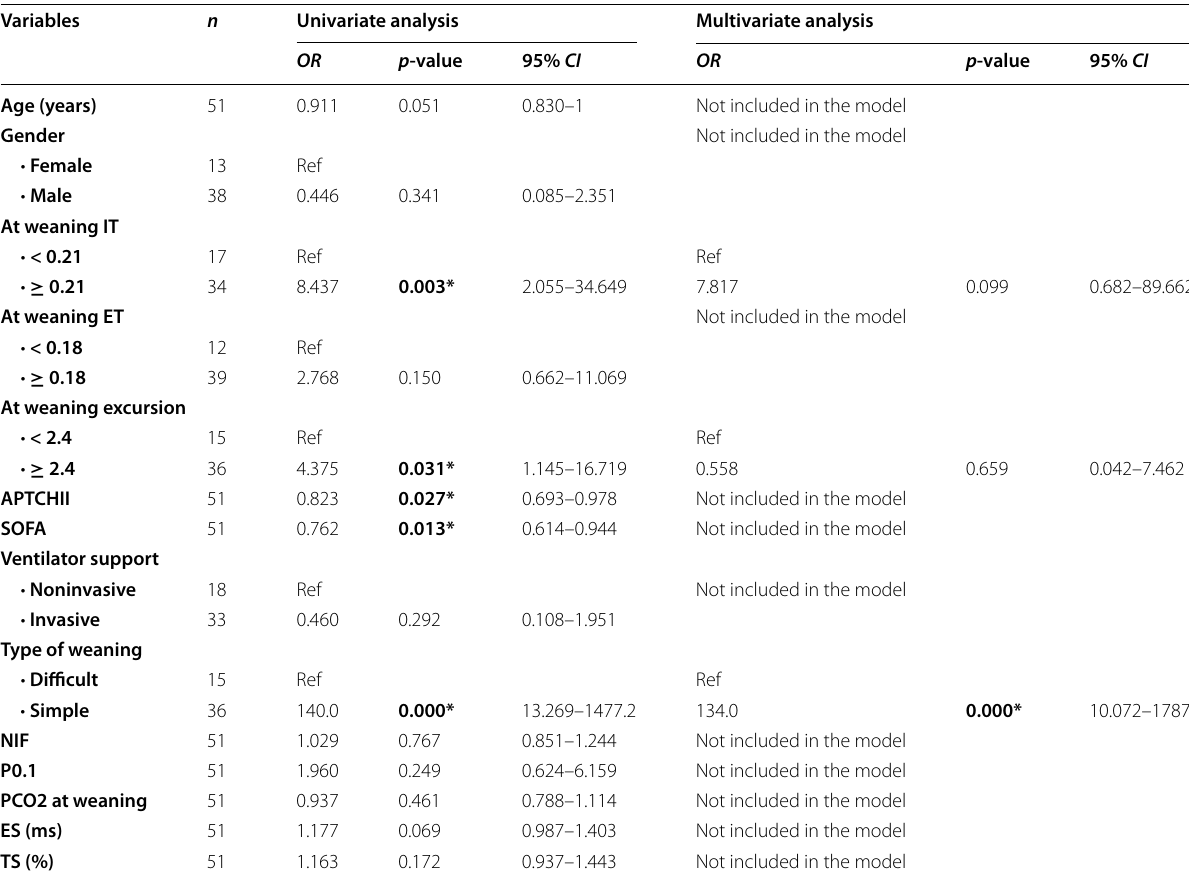
Table 7 Predictors of successful weaning in group 1 COPD patients by univariate and multivariate analyses using logistic